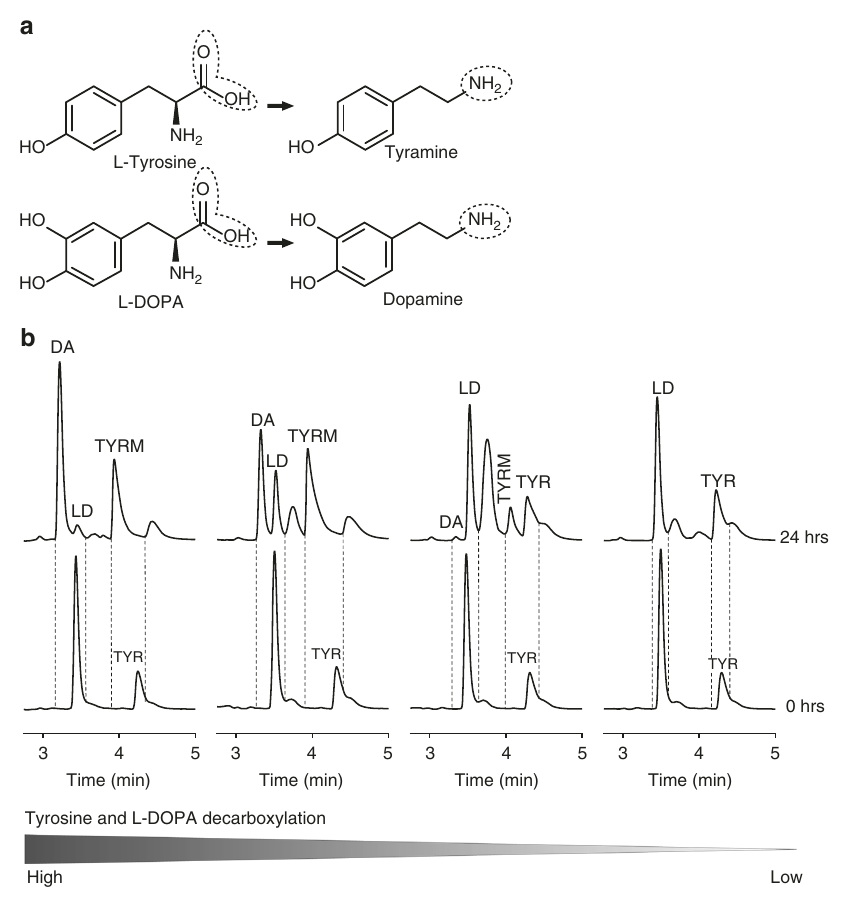
Fig. 1 Bacteria in jejunal content decarboxylate levodopa to dopamine coinciding with their production of tyramine ex vivo. a Decarboxylation reaction for tyrosine and levodopa. b From left to right coinciding bacterial conversion of tyrosine (TYR) to tyramine (TYRM) and 1 mM of supplemented levodopa (LD) to dopamine (DA) during 24 h of incubation of jejunal content. The jejunal contents are from four different rats ranked form left to right based on the decarboxylation levels of tyrosine and levodopa, showing that tyrosine decarboxylation is coinciding with levodopa